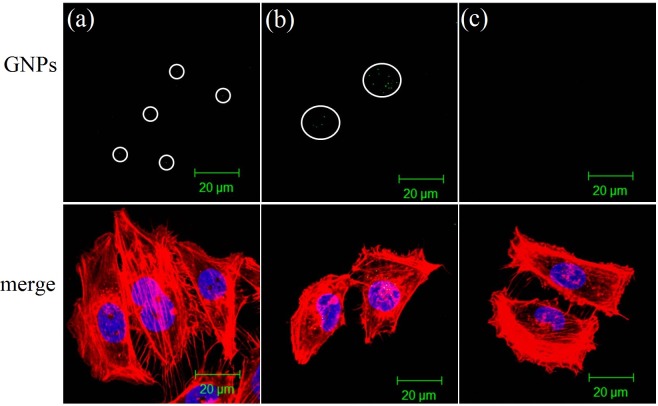
LSCM fluorescence images of MG63 after uptake of GNPs.LSCM fluorescence images of (a) MG63 cells treated with GNPs at a concentration of 1 ppm, (b) 10 ppm, and(c) normally cultured cells. Cytoskeletal F-actin (red) are stained with Texas Red-X phalloidin. Cell nuclei (blue) are stained with Hoechst 33258. The green spots in the circled areas are GNPs.